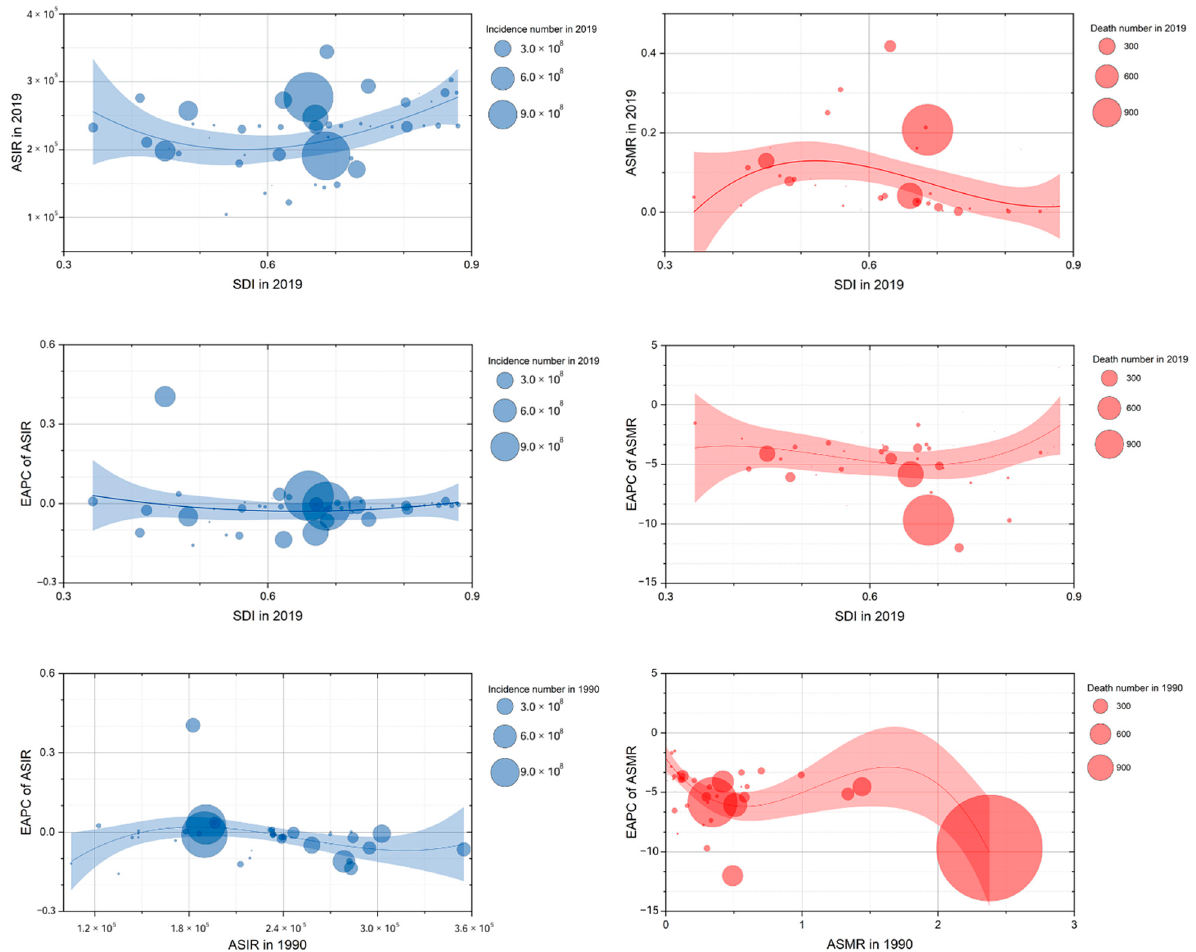
Figure 7. The correlation between ASIR/ASMR of upper respiratory infections and SDI (in 2019), EAPC of ASIR/ASMR and SDI (in 2019), and EAPC of ASIR/ASMR and ASIR/ASMR (in 1990), in Asian countries. ASIR, age-standardized incidence rate; ASMR, age-standardized mortality rate; SDI, Socio-demographic Index; EAPC, estimated annual percentage change.